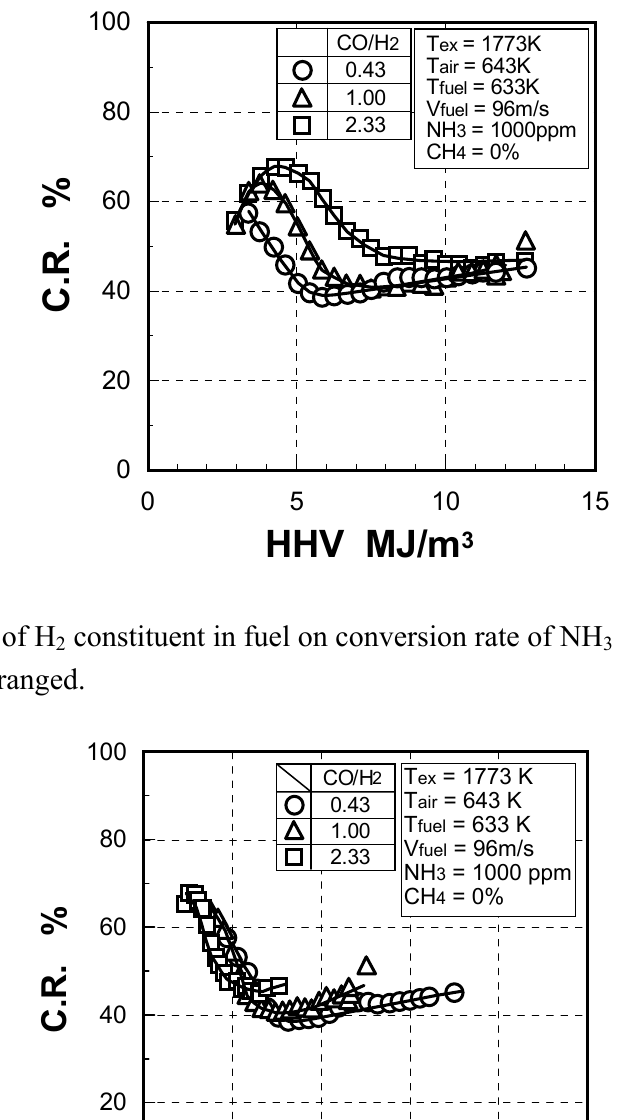
Figure 13. Effects of gasified fuel calorie on conversion rate of NH of fuel including no methane.